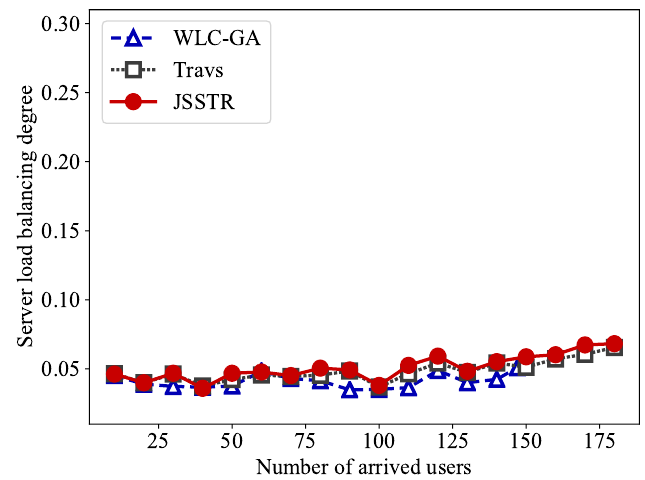
Figure 9. Server load balancing degree comparison for JSSTR, Travs and